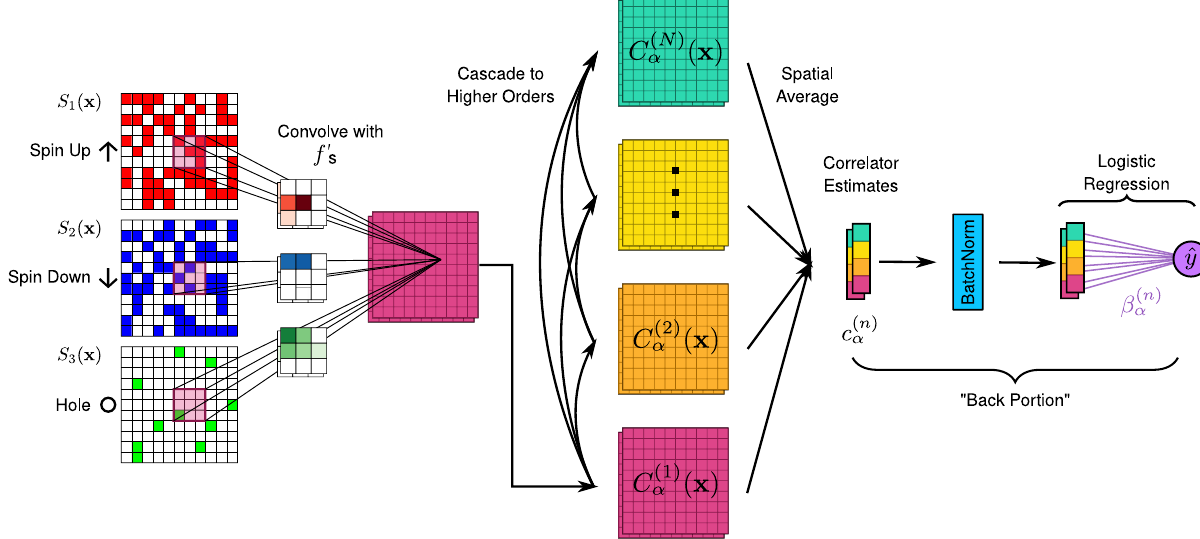
Fig. 1 Correlator Convolutional Neural Network Architecture. The construction of our Correlator Convolutional Neural Network, shown here with two learnable fi lters ( M = 2). The input is a three-channel image: S 1 ( x ) = n ↑ ( x ), S 2 ( x ) = n ↓ ( x ), S 3 ( x ) = n hole ( x ) = 1 − S 1 ( x ) − S 2 ( x ). Note that S 3 is redundant information, but is provided for improved performance and interpretability. The image is fi rst convolved with learned fi lters f α to produce a set of convolutional maps C ð 1 Þ α ð x Þ . Maps containing information about higher-order local correlations can then be recursively constructed using the lower-order maps, truncating at some order N . Spatially averaging these maps produces features c ð n Þ α which in expectation are equal to weighted sums of correlators found as subpatterns of the corresponding convolutional fi lter. These features are normalized to zero mean and unit variance by a BatchNorm layer, then used by a logistic classi fi er with coef fi cients β ð n Þ α to produce the fi nal output ^ y